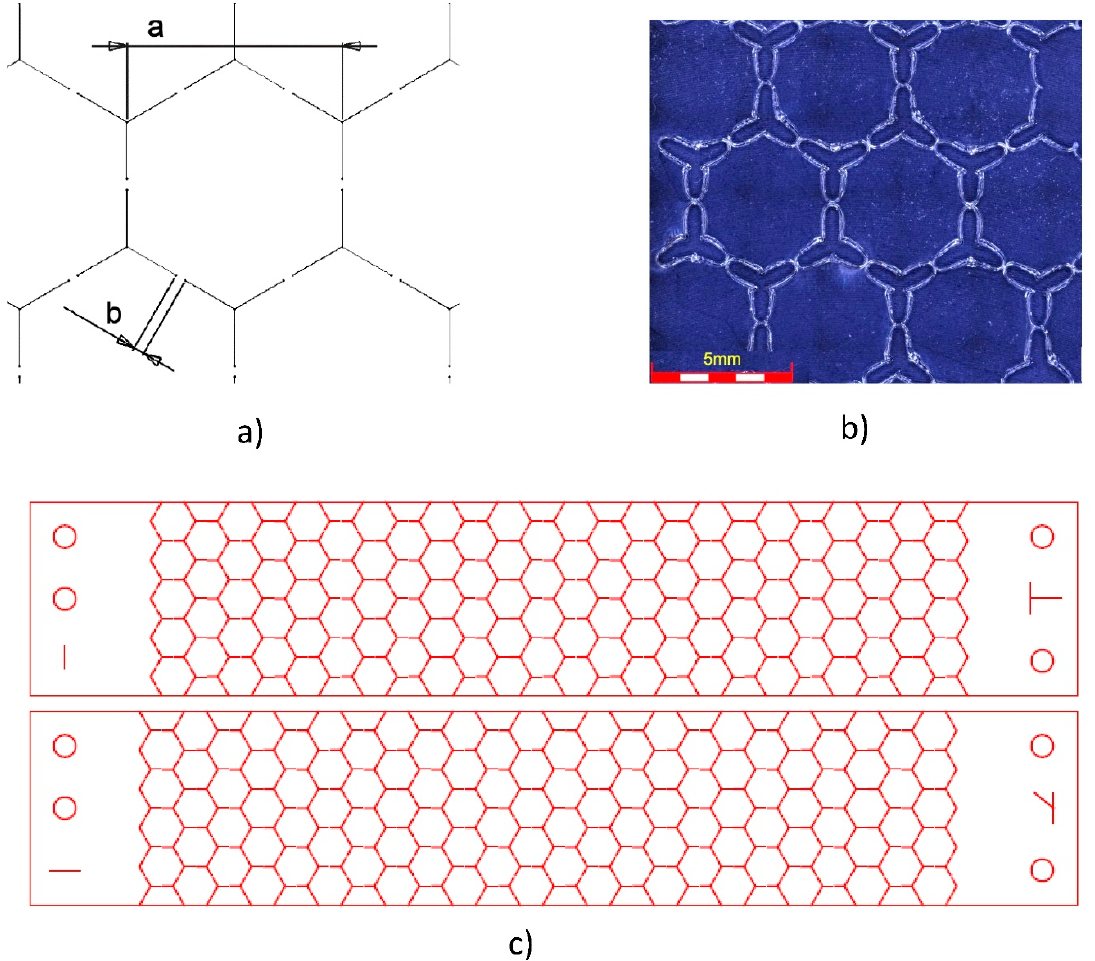
Figure 1. Polystyrene Laser cutting. ( a ) Designed cut lines ( b ) Laser cut view under a microscope ( c ) Laminate cut design with guide holes and orientation labels.